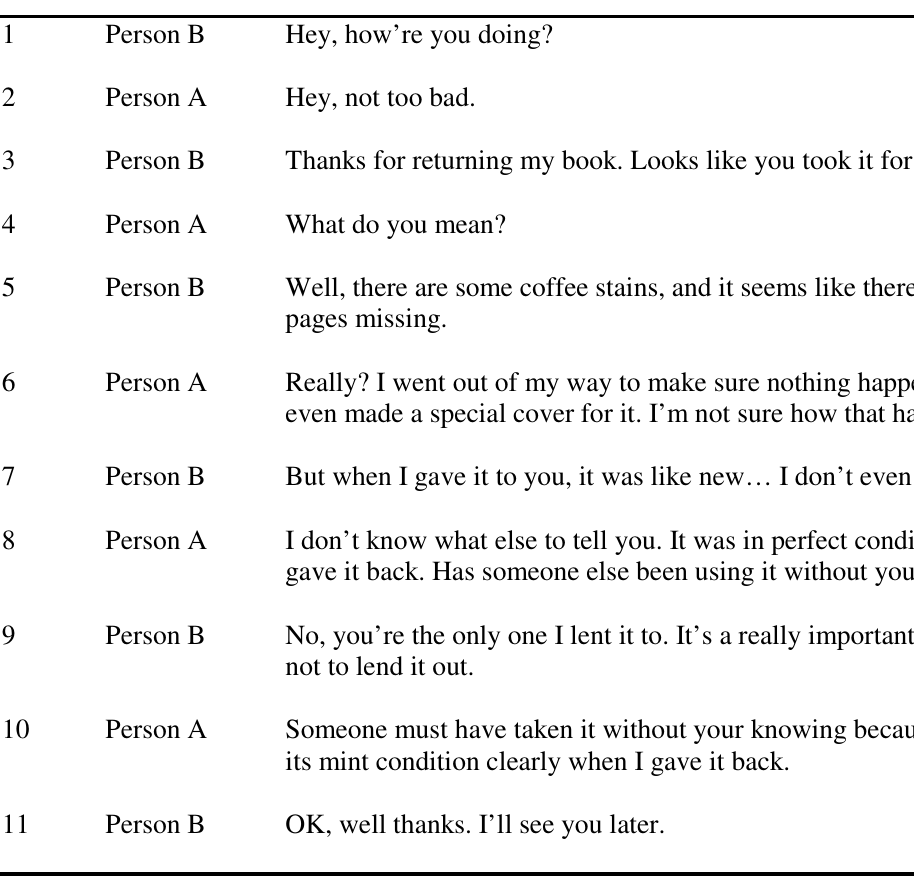
Sample 1/Task 2/Person 39A and Person